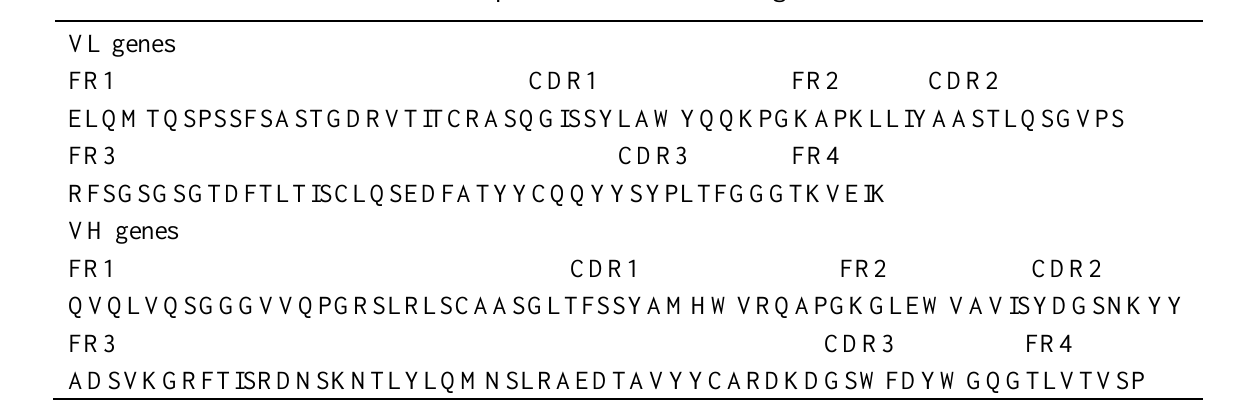
Table 2. Amino acid sequences of VL and VH genes of htesFab clone.